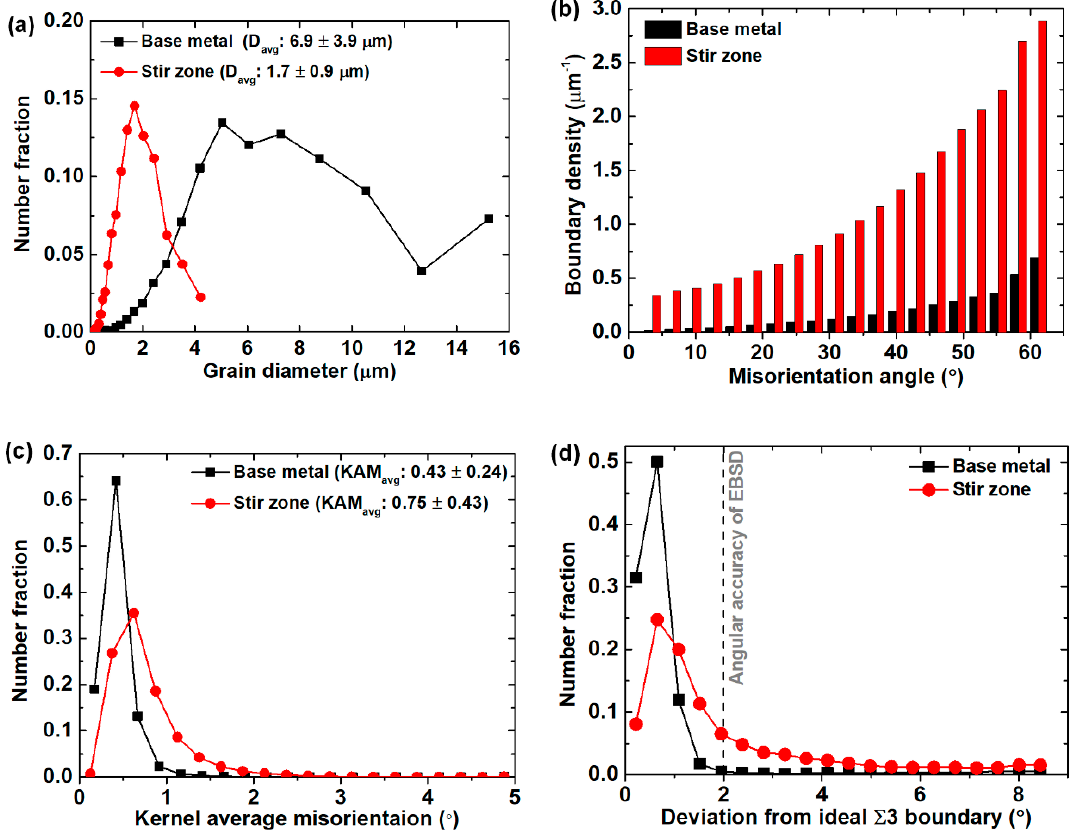
Figure 2. Distribution of ( a ) grain diameter, ( b ) misorientation angle, ( c ) kernel average misorientation, and ( d ) the misorientation deviation measured along the ideal Σ 3 twin boundaries in the base metal and stir zone specimens.